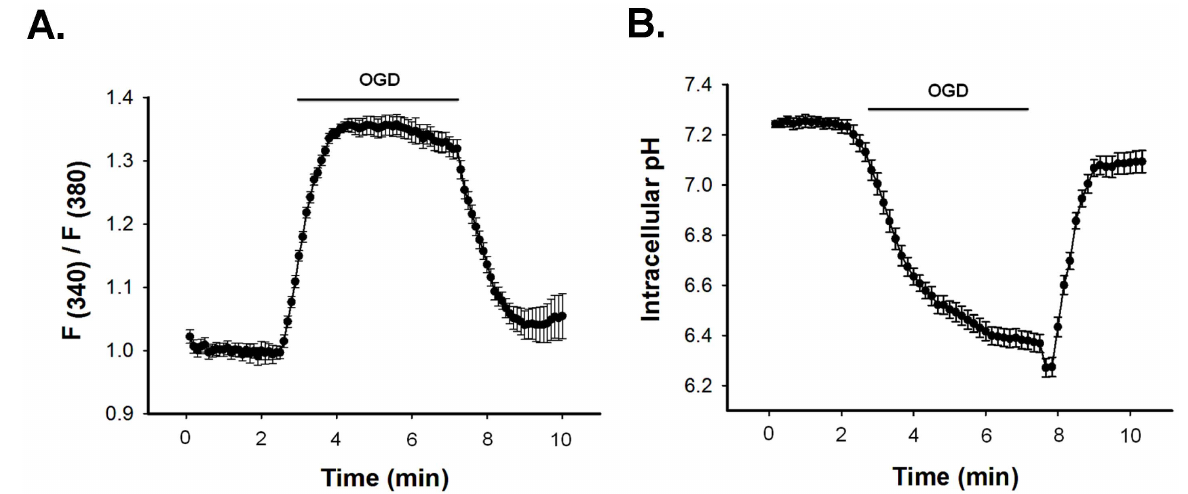
Figure 4. OGD increases intracellular calcium ([Ca 2 + ] i ) and decreases intracellular pH (pH i ). OGD induced rise of [Ca 2 + ] i and decrease of pH i in N2a cells are shown in A and B. [Ca 2 + ] i and pH i were measured ratio-metrically using Fura-2 and BCECF dye. Fluorescence intensity was calculated from background subtracted images using ANDOR IQ programme. Values are the mean 6 SEM of 20–25 cells.